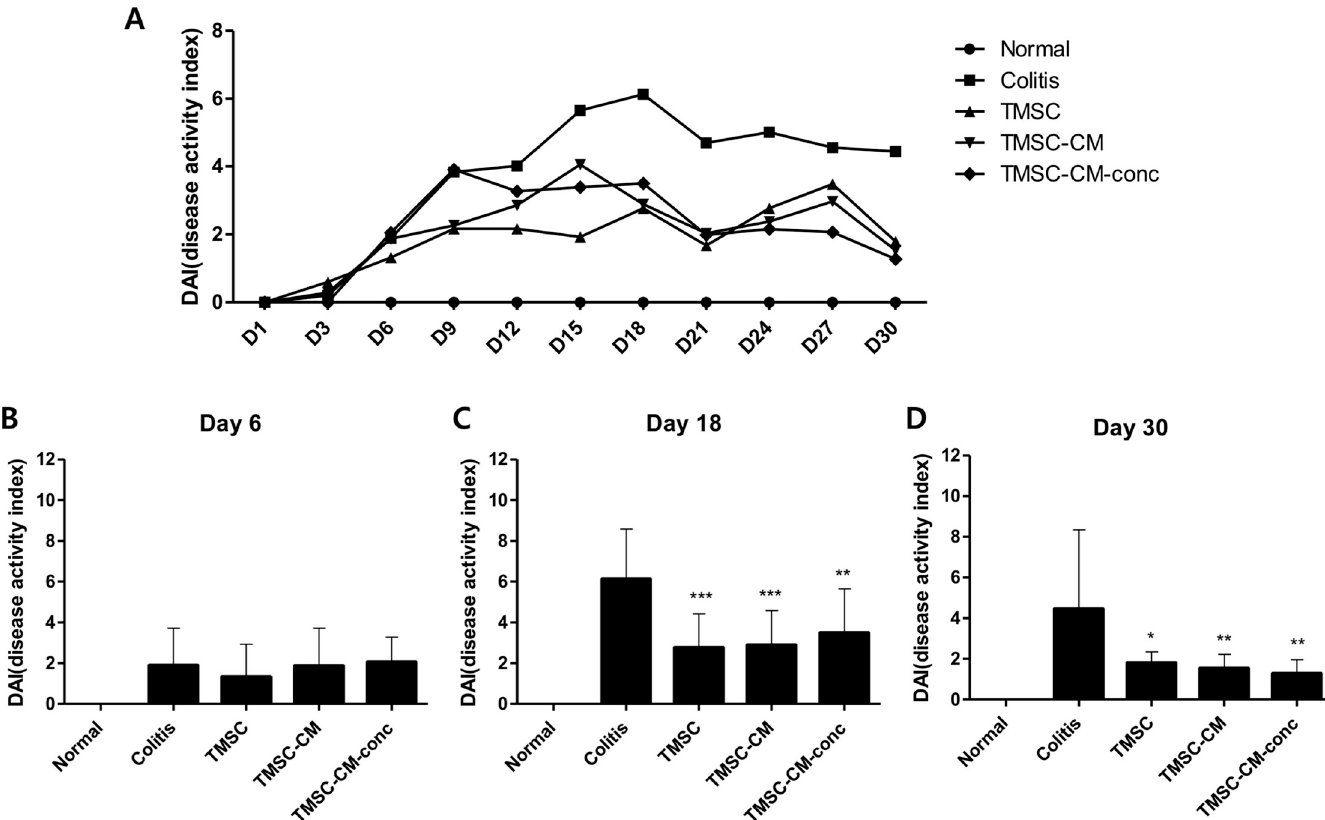
Fig 4. Disease activity index (DAI). DAI was significantly decreased in TMSC, TMSC-CM, and TMSC-CM-conc group compared to the colitis control group at the 18th, 30th day of experiment. (mean with standard deviation, � p < 0.05, �� p < 0.01, ��� p <